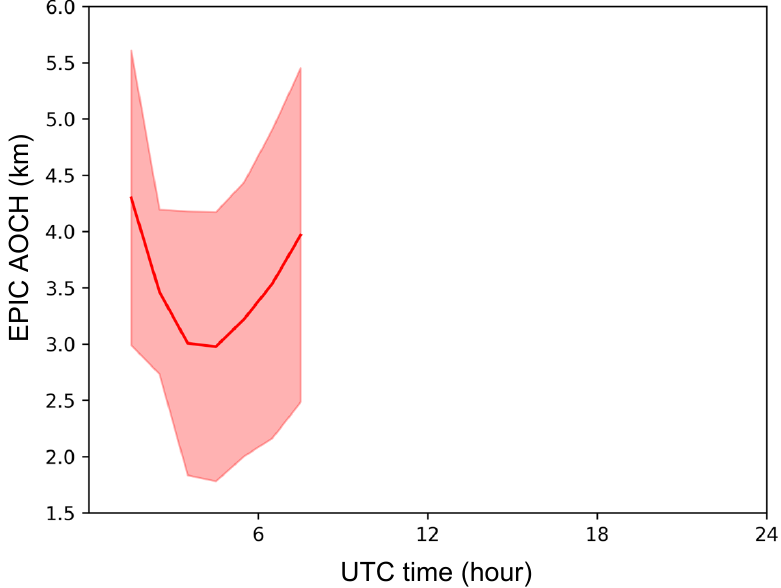
Figure A1. Diurnal cycle of July–November 2016–2018 EPIC aerosol optical centroid heights (AOCH) for the Southeast Asian region outlined in Figure